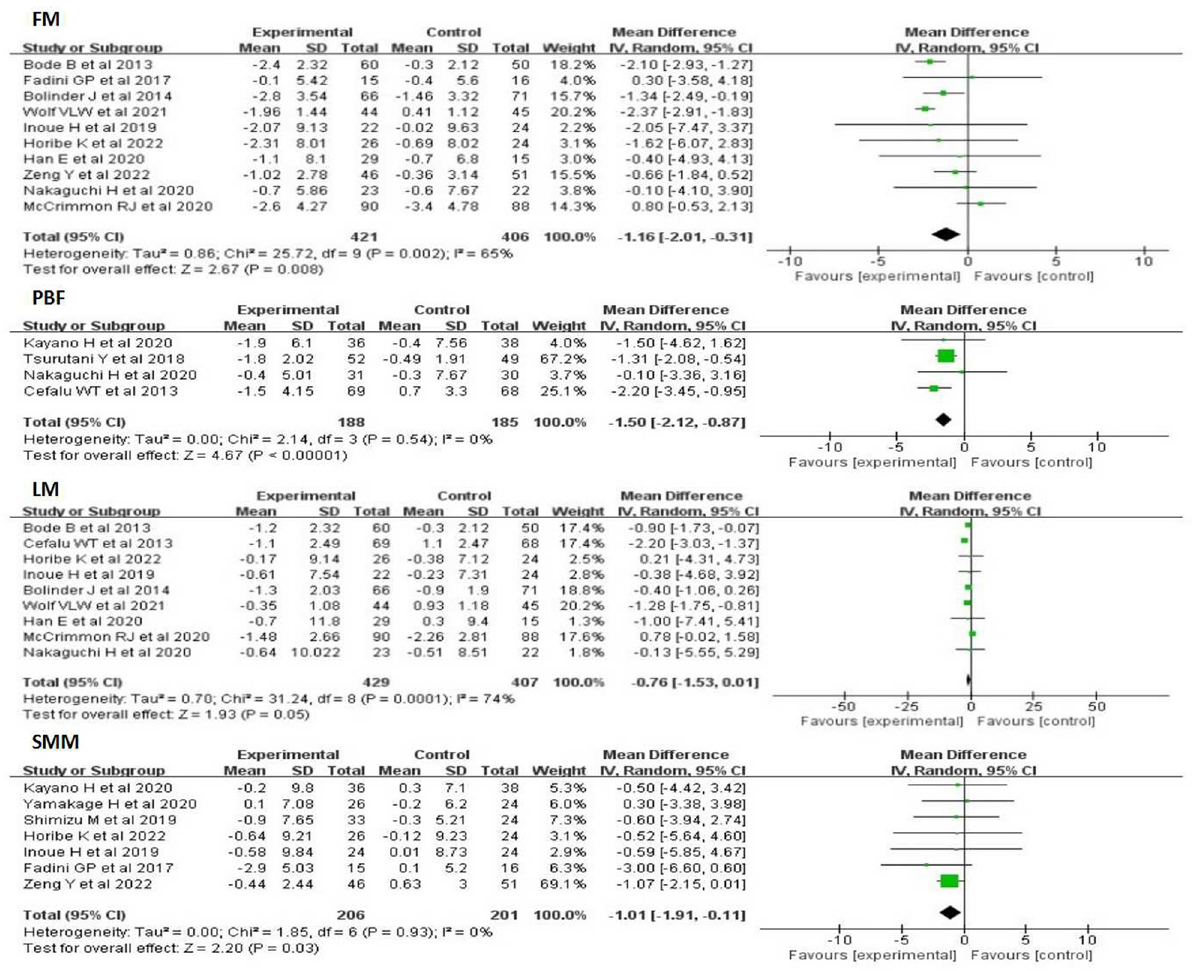
Fig 4. Forest plots depicting FM, PBF, LM and SMM comparisons between SGLT-2 inhibitors and the control group.